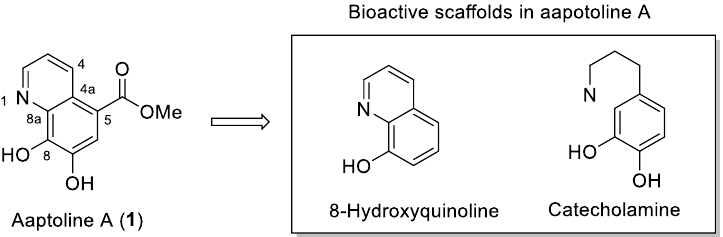
Figure 1. Proposed structure of aaptoline A ( 1 ) and its embedded privileged scaffolds.